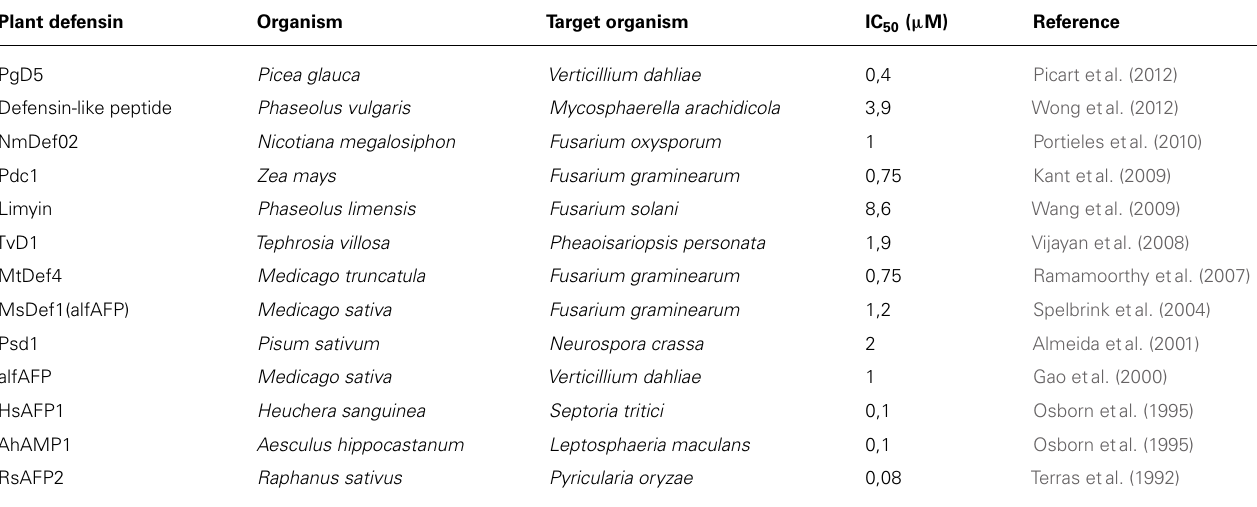
Table 1 | Short sample of plant defensins and its IC 50 concentration against its fungal